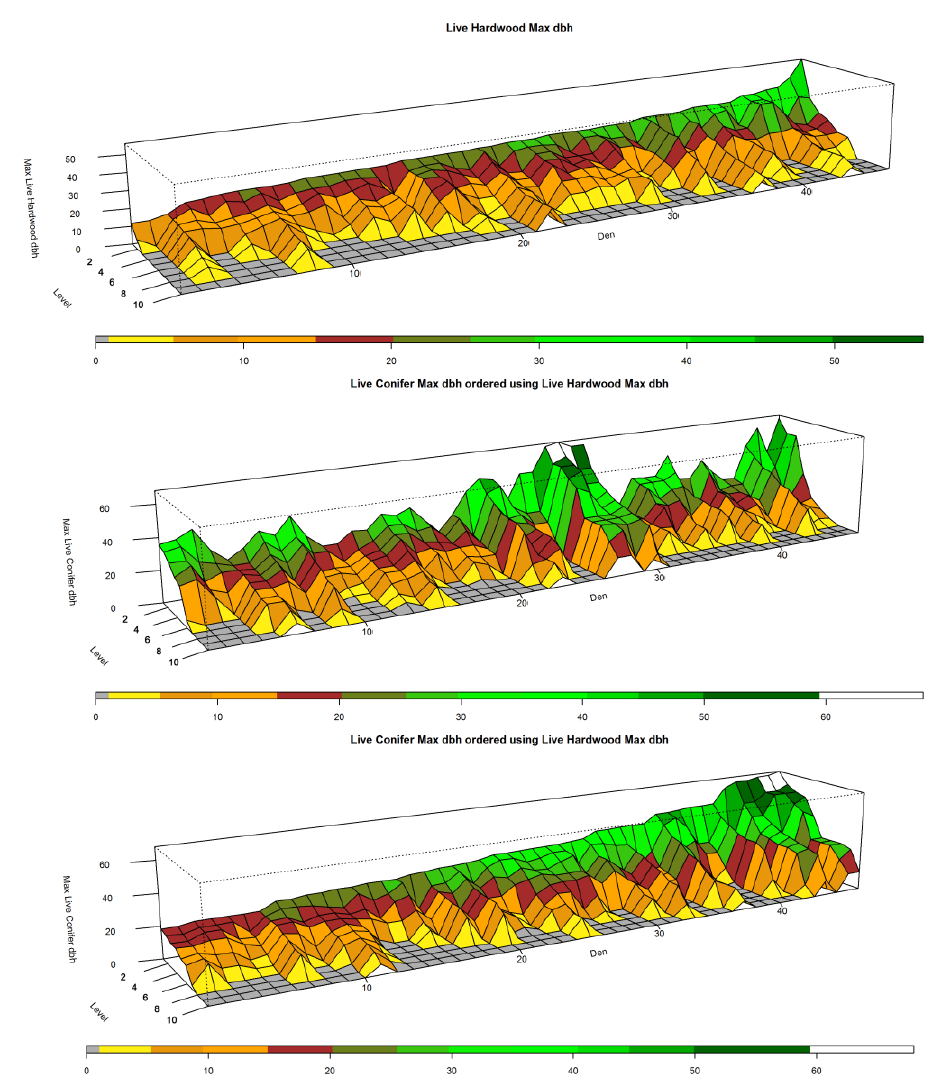
Figure 3. Sorted Den NCs for Live Hardwood Maximum dbh and Live Conifer Maximum dbh, in inches. The top panel shows the Live Hardwood Maximum dbh sorted by Den from low to high for the highest ranked plot in each NC (that is, l = 1). The middle panel shows Live Conifer Maximum dbh using the same Den sorting from the top panel. The bottom panel shows the den NCs sorted by the highest ranked plot in each NC in terms of the largest conifer found.